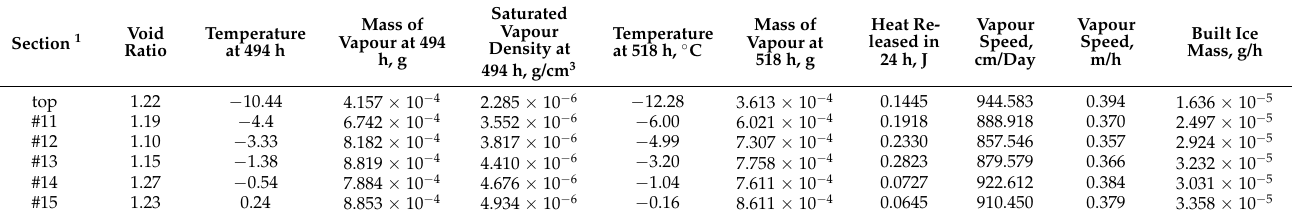
Table 4. Calculation of soil parameters for the 24 h time interval for column